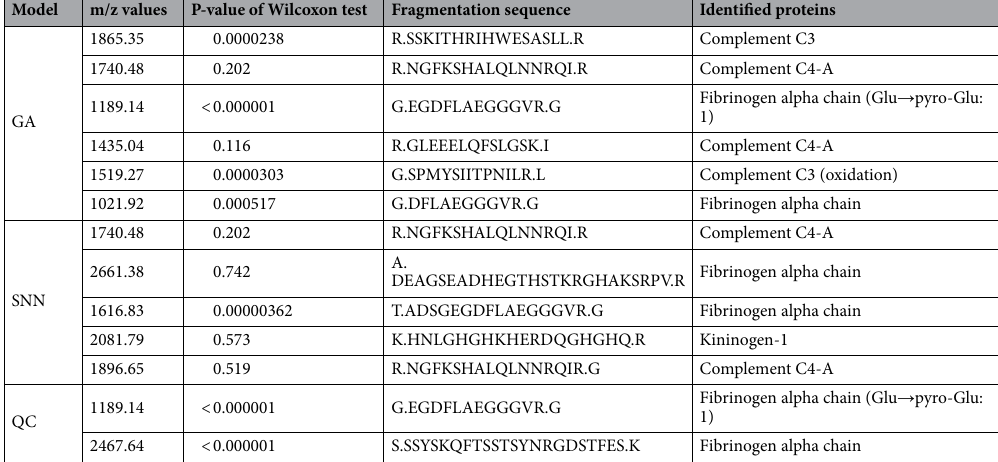
Table 4. Identified proteins classified as discriminative between studied